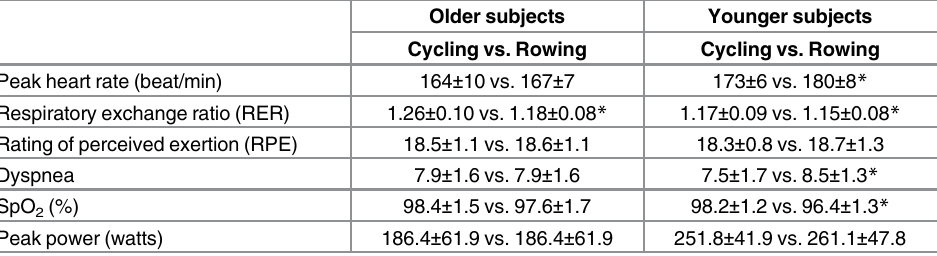
Table 2. The assessment of exertion at peak level. Older subjects Younger subjects Cycling vs. Rowing Cycling vs.